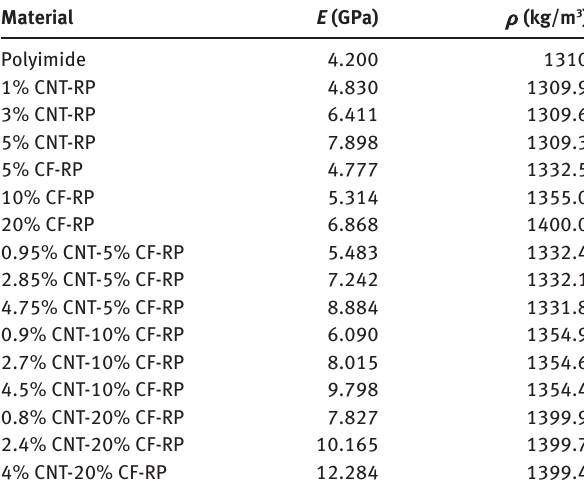
Figure 5: Forced vibration behavior of clamped circular plate.